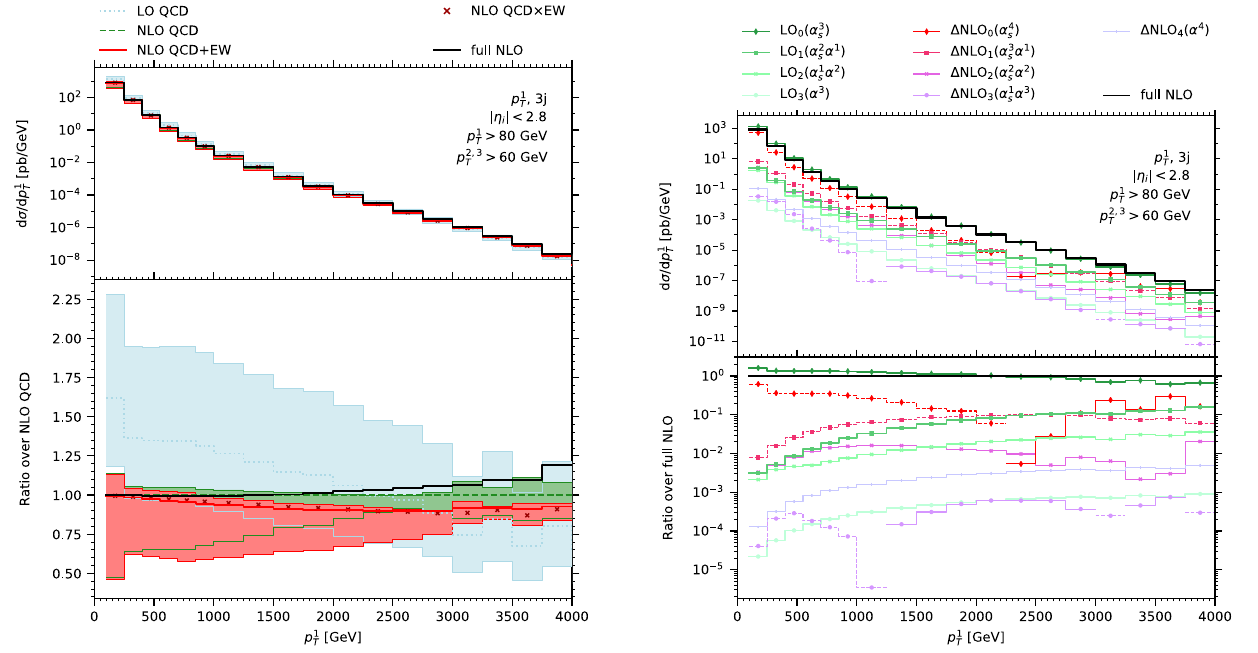
Fig. 3 Leading jet transverse momentum in three-jet production. Left: Theoretical uncertainties at LO, NLO QCD, NLO QCD+EW and full NLO. Right: Decomposition of the full NLO result in its contributions defined in Eq. (4)